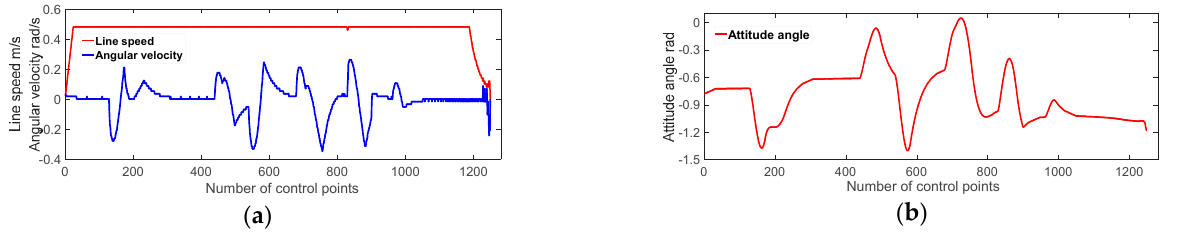
Figure 24. Global optimal path of the robot.